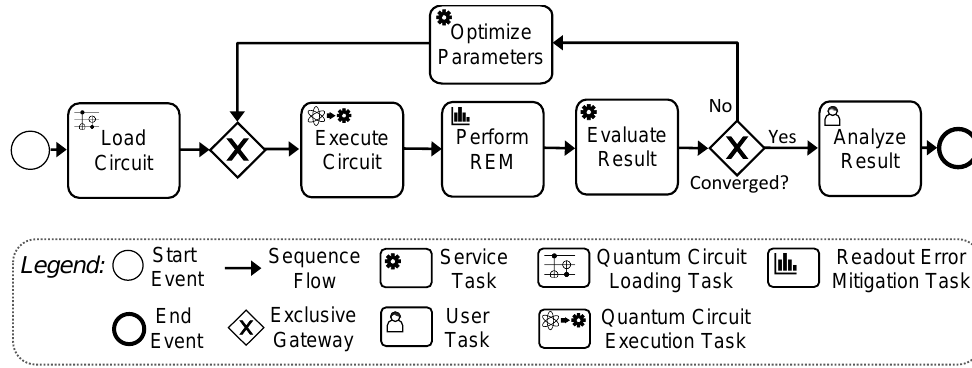
Figure 2. Overview of a typical QuantME BPMN model for a VQA.